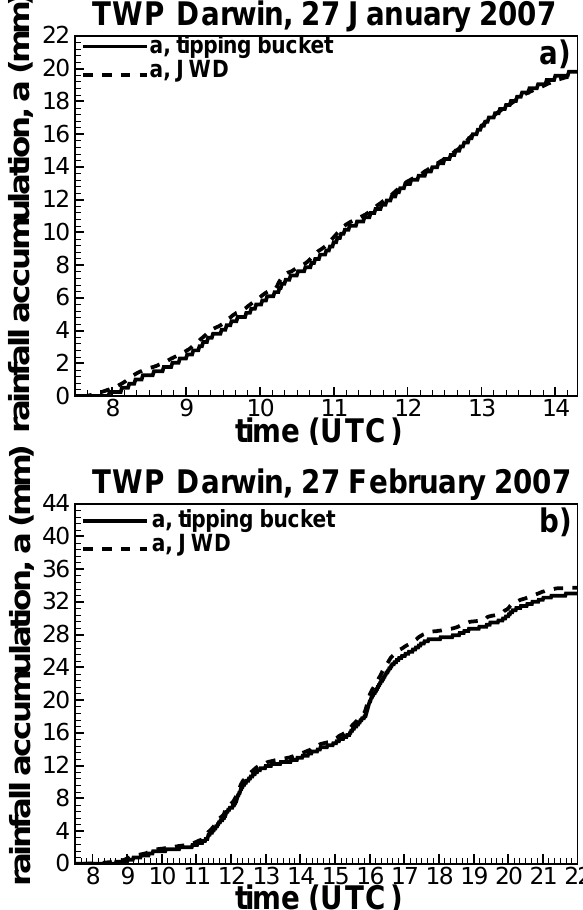
Fig. 4. Time series of rainfall accumulation from the JWD and rain gauge at the TWP Darwin site for the events of 27 January 2007 (a) and 27 February 2007 (b)